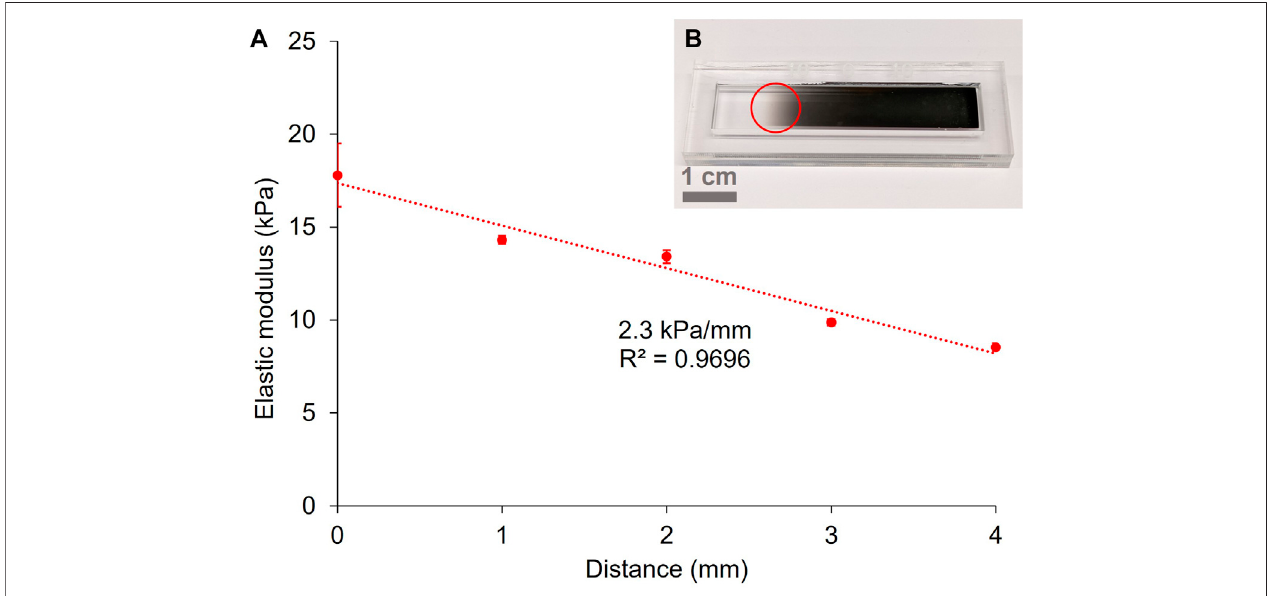
FIGURE 4 | Gradient of stiffness on a 10 wt% GelMA hydrogel crosslinked for 4 min under the green LED (A) (error bars = standard deviation of the force maps). Photographofthegradient fi lter(0.04 – 4.0OD)usedforthepatterningofhydrogels (B) .Theredcirclerepresentstheapproximatepositionofthesampleunderthemask.